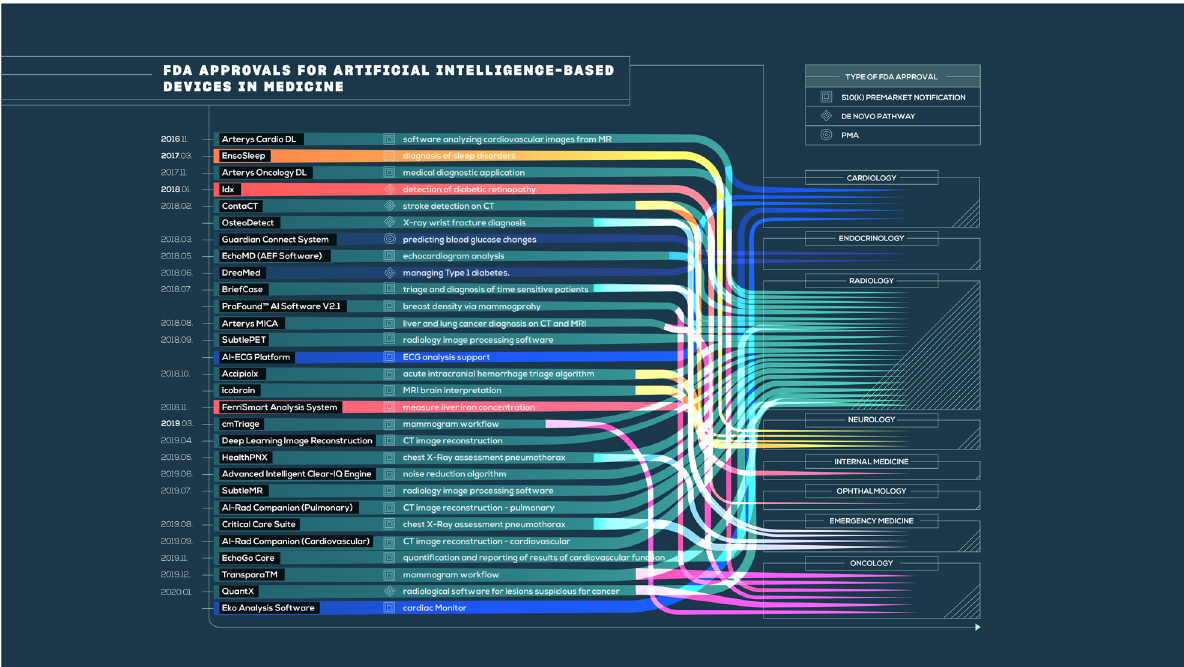
Fig. 1 An infographic about the 29 FDA-approved, AI/ML-based medical technologies. The devices have features such as date and type of FDA approval; name of the device, its short description and which primary and secondary medical specialty it is related